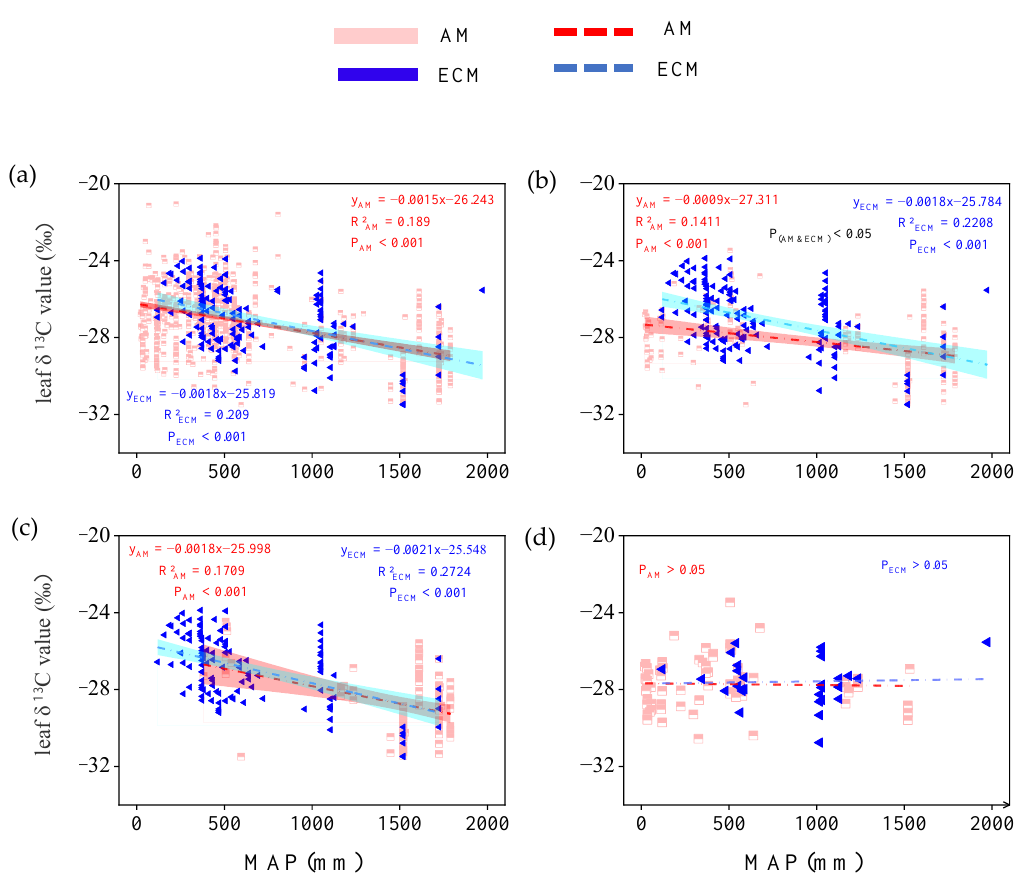
Figure 4. The relationship between leaf δ 13C in AM plants and ECM plants with different life forms and mean annual precipitation (MAP, mm). ( a ) Total plants, include all plants in the database without distinguishing their life forms. ( b ) Trees, only contain all the tree species in the database. ( c ) Evergreen trees, only contain all evergreen trees of the tree species. ( d ) Deciduous trees, only contain all deciduous trees of the tree species. The red broken line means AM, the blue broken line means ECM. The red and cyan bands represent, respectively, the prediction intervals of AM and ECM plants. P(AM and ECM) represents the significant difference in the slope of the two regression lines. When all vegetation types were considered, leaf δ 13 C in AM plants and ECM plants both decreased significantly with increasing MAT (P AM < 0.001; P ECM < 0.05). The slope of leaf δ 13 C in AM plants across MAT is twice as large as it is in ECM plants (Figure 5a). When only evergreen trees were considered, leaf δ 13 C in AM plants and ECM plants was also positively related to MAT, while the response of leaf δ 13 C to MAT tended to be more sensitive in AM plants (slope = 0.10) in comparison to ECM plants (slope = 0.06; Figure 5c). By contrast, leaf δ 13 C in AM plants and ECM plants had no correlation with MAT, in deciduous trees (Figure